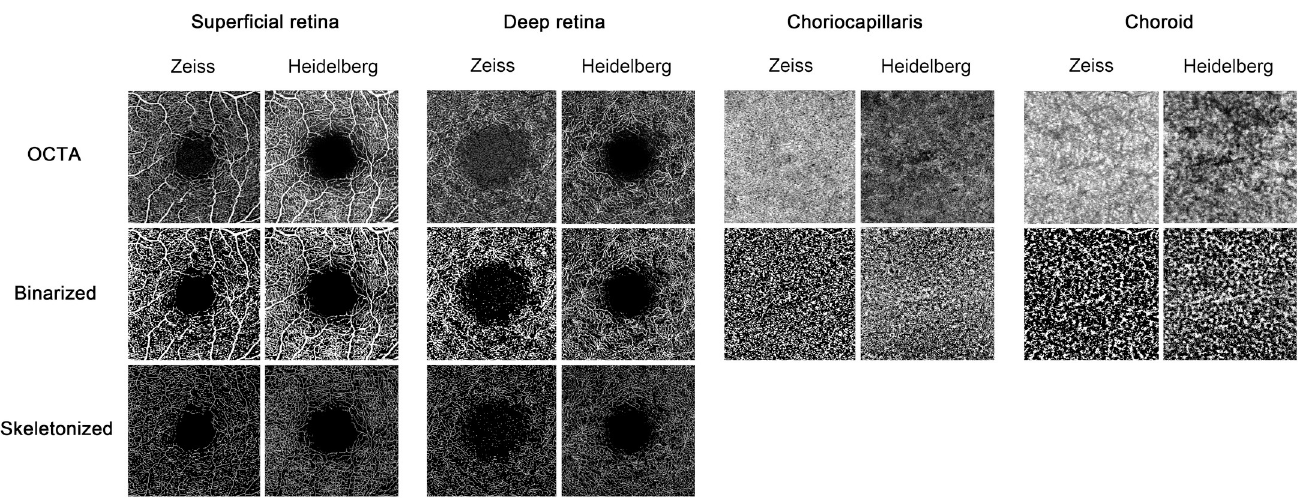
Fig 1. Comparison of images acquired from Zeiss and Heidelberg devices. Optical coherence tomography angiography (OCTA) images, binarized images, and skeletonized images of the superficial and deep retina, choriocapillaris, and choroid using two different OCTA devices to examine a 46-year-old woman with diabetes and no